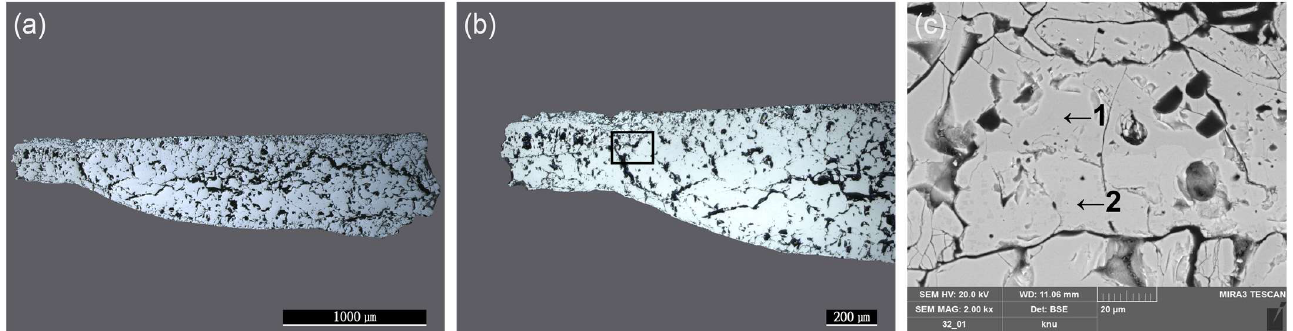
Figure 9. Microstructure and SEM image of flake hammer scale (No. 3): ( a ) whole image, ( b ) metallographic microscope detailed image and rectangle is position of the SEM analysis, ( c ) position of SEM image and EDS analysis; 1: magnetite, 2: wüstite. Table 4. EDS analysis of flake hammer scale (No. 3).